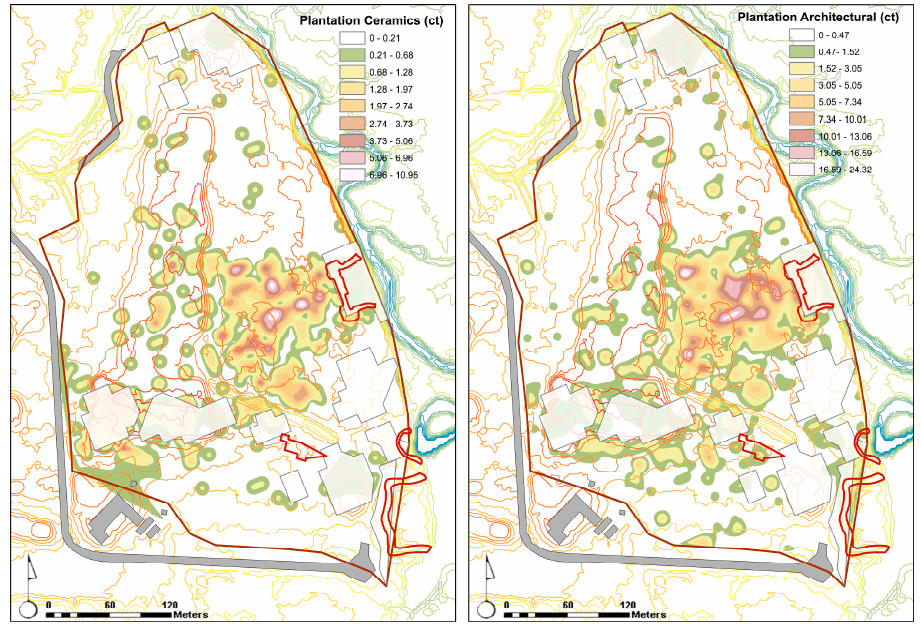
Figure 23. The distribution of Plantation period ceramics ( left ) and architectural materials ( right ) recorded through a shovel test survey. Areas whited-out were not shovel tested. Contour spacing is 1 m. Contours are based on the LiDAR dataset and use the NAD 1983 and NAV 1988 horizontal and vertical datum, respectively.